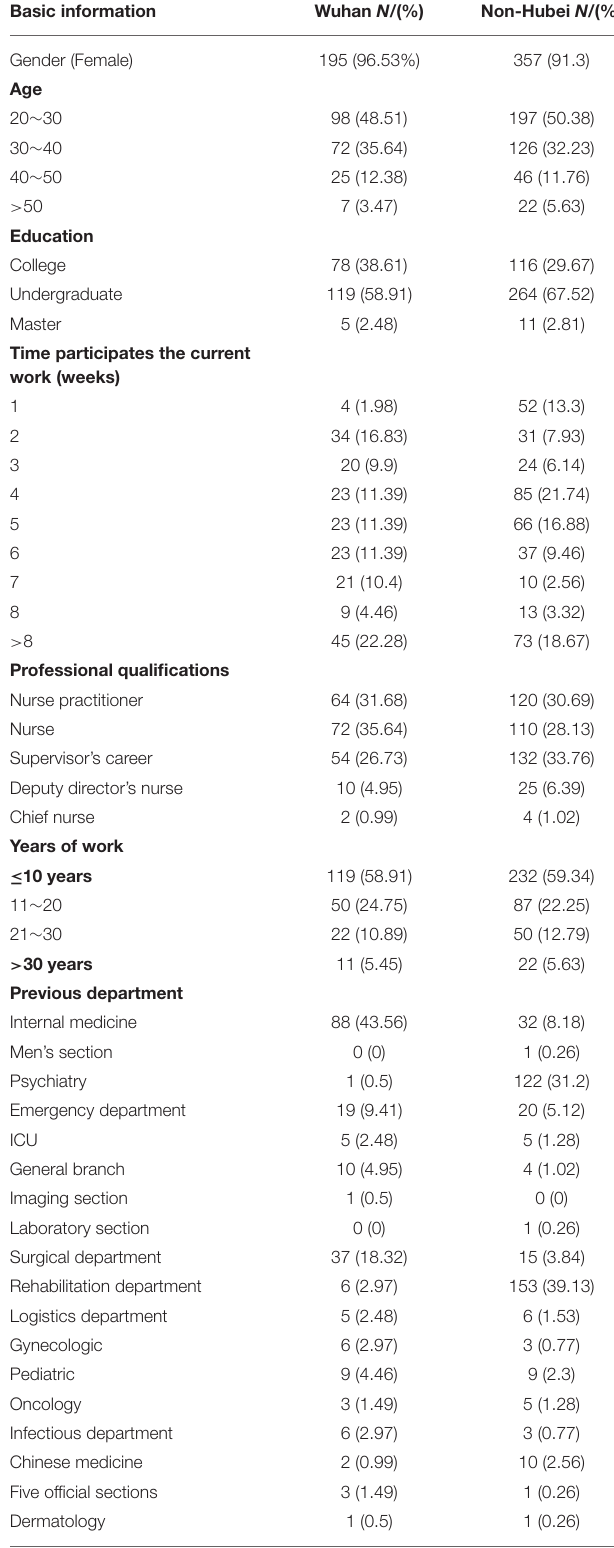
TABLE 1 | Demographics characteristics of nurses on